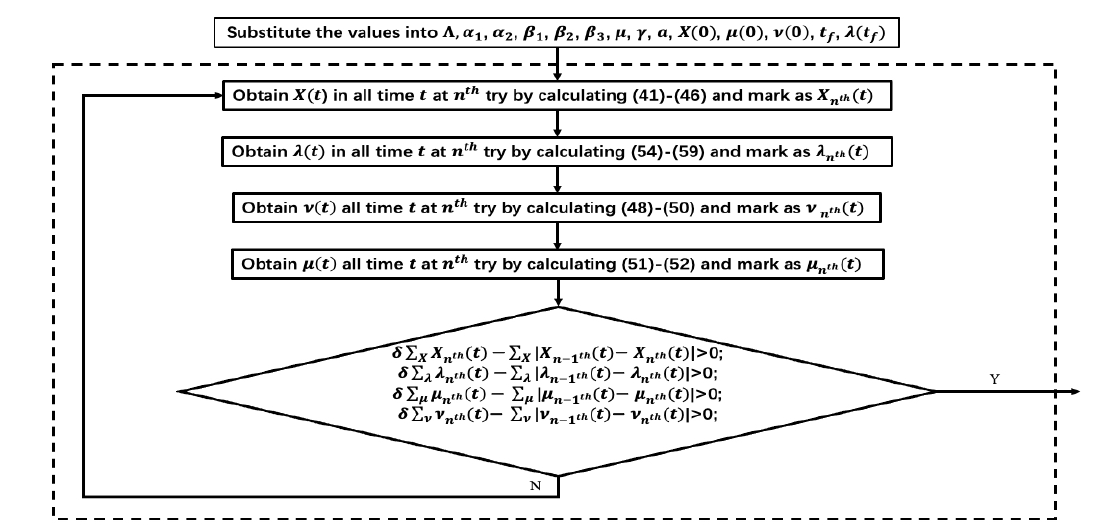
Figure 6. Flow diagram of Forward–Backward Sweep (FBS)